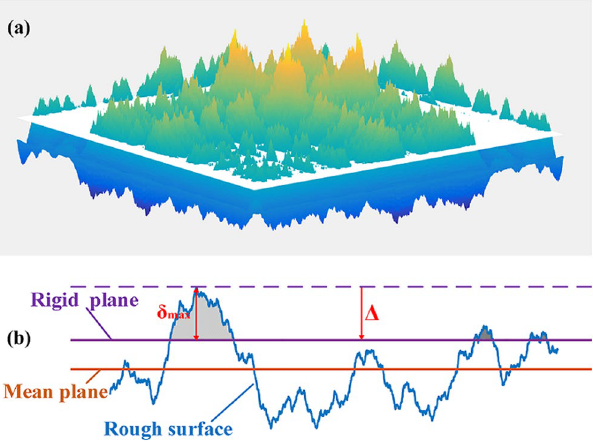
Figure 1. ( a ) One undeformed rough surface (in color) with one smooth rigid plane (white), and ( b ) the 2D section of the